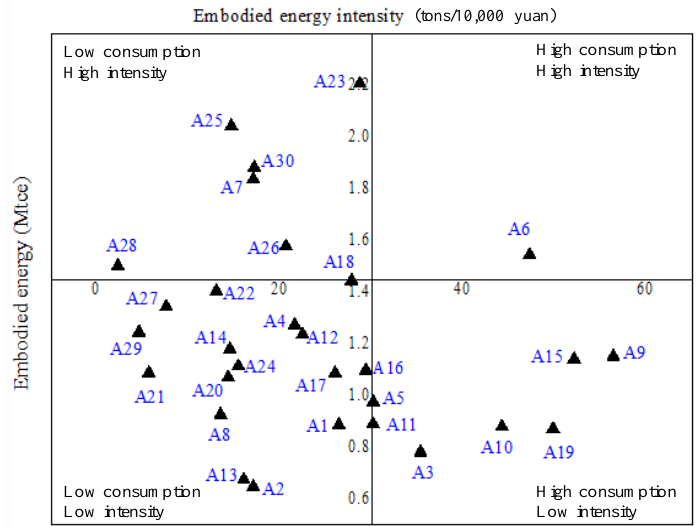
Figure 3. Provinces’ division on the basis of dual criteria.